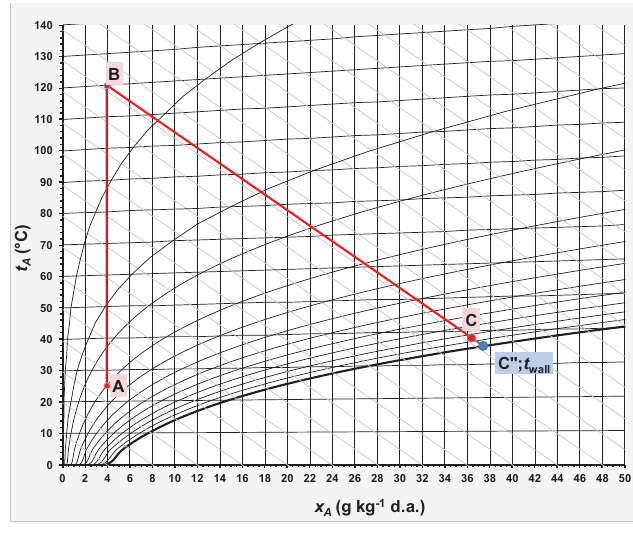
Fig. 4 – Drying air parameters in the h – X diagram of wet air for the adiabatic drying process; A – B drying air heating; B – C particle drying